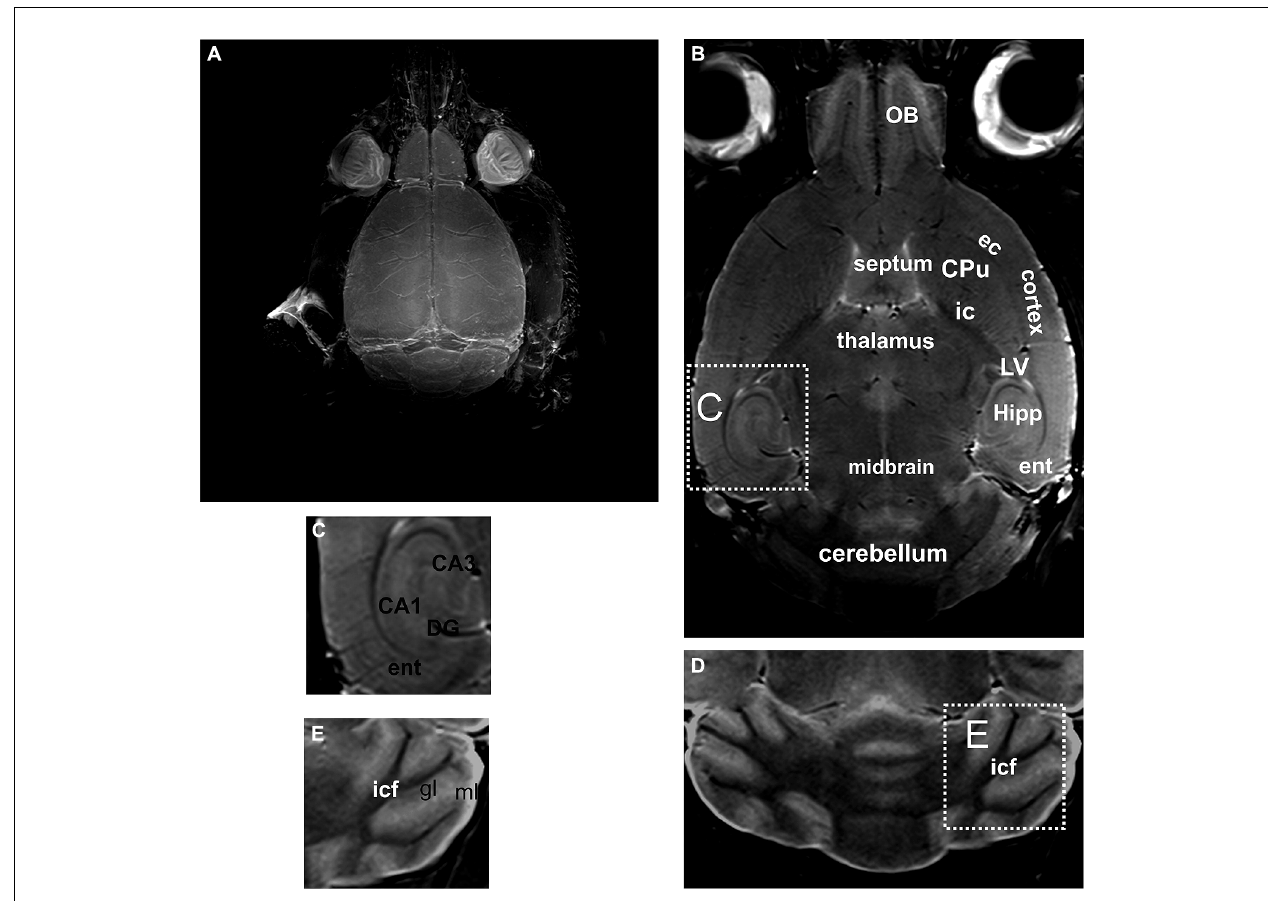
is composed of a single layer of relatively large neurons, cannot be detected (a higher magnification of this area is shown in E) . CA1, CA3, hippocampal area; CPu, caudate putamen; DG, dentate gyrus; ec, external capsule; ent, entorhinal cortex; gl, granular layer of the cerebellum; Hipp, hippocampus; ic, internal capsule; icf, intercrural fibers; LV, lateral ventricle; ml, molecular layer of the cerebellum; OB, olfactory